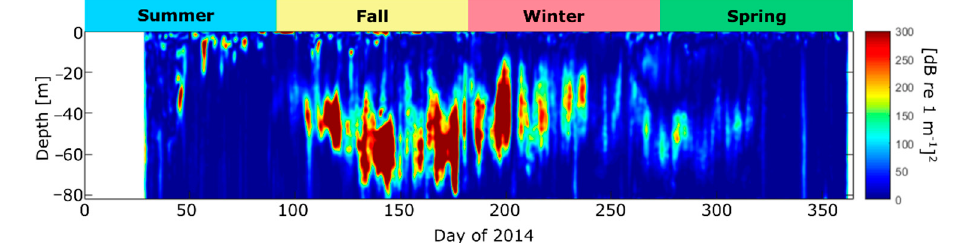
Figure 9. Wavelet analysis of the diurnal frequency of S v at each depth bin for the entire 2014 time series.